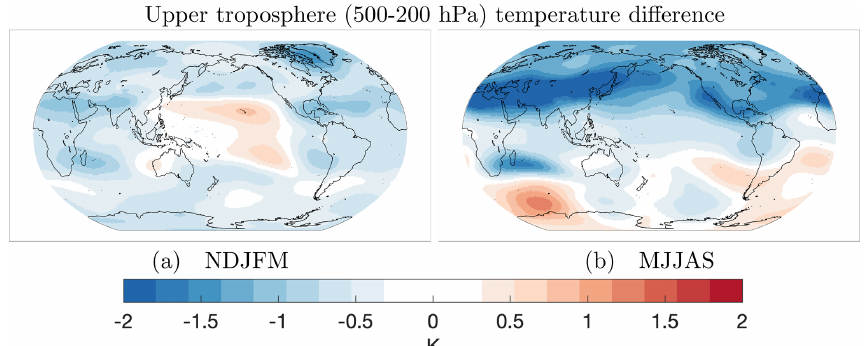
Figure 10. Seasonal differences between the fully coupled E3SM and AMIP simulation for upper troposphere (500–200hPa) temperature.